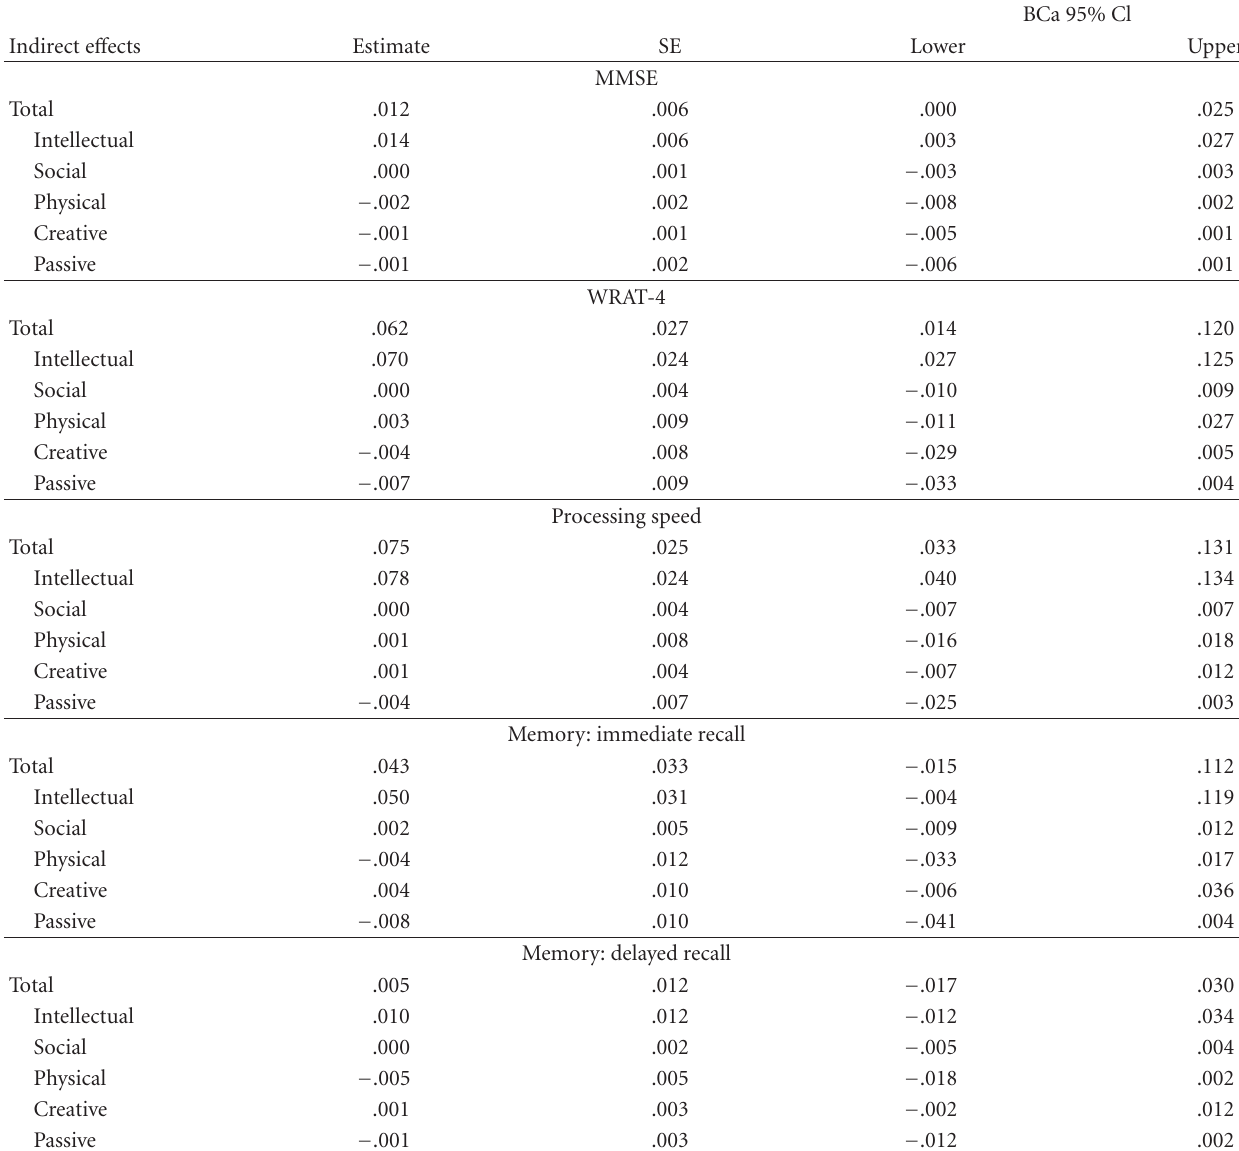
Table 4: Indirect e ff ects of education on cognition through